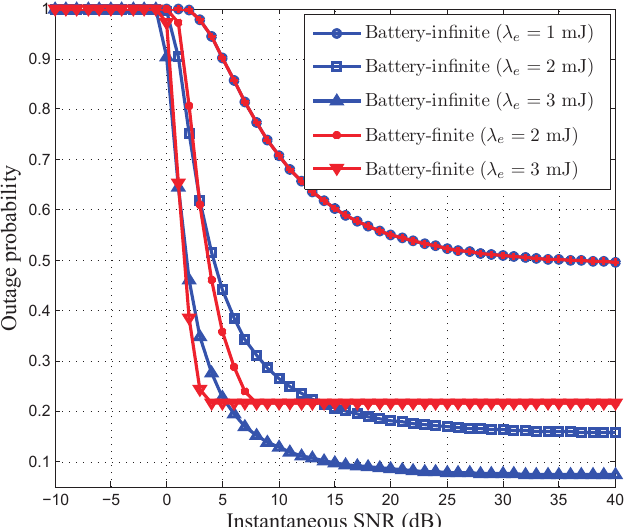
Figure 11. The outage probability of our developed optimal power control policy with α = 4, λ e = 3 mJ, and B max = 1.5 mJ.